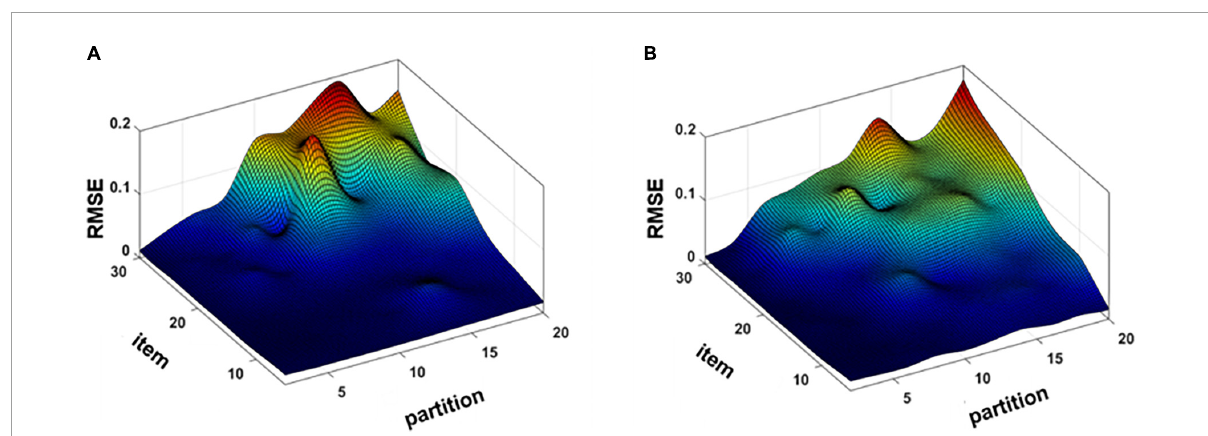
FIGURE7 (A) Mean root-mean-square error (RMSE) map of the real experiment (A) K-mean angle similar (KS) and (B) K-means (KM).